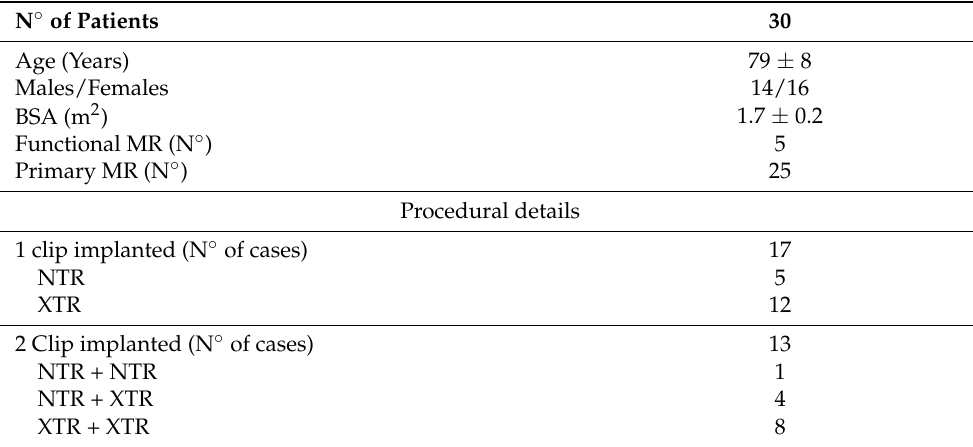
Table 1. Clinical and procedural characteristics of the study population.